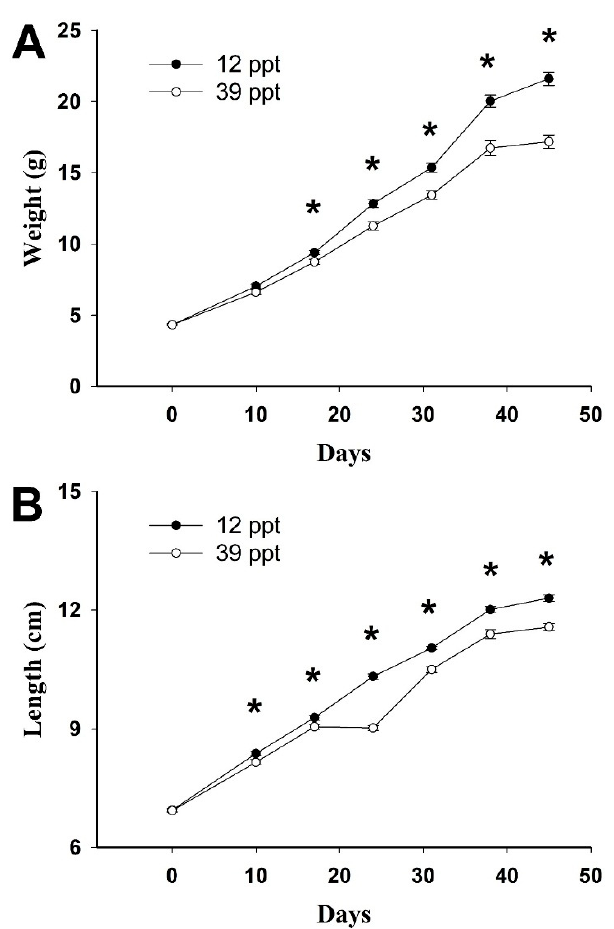
Figure 1. Body weight ( A ) and length ( B ) development in Argyrosomus regius fingerlings acclimated to 12 (black dots) and 39 (white dots) ppt salinity conditions for 45 days. Data are expressed as the mean ± SEM ( n = 120). Asterisks (*) indicate significant differences among groups ( p < 0.05, Student’s t -test).